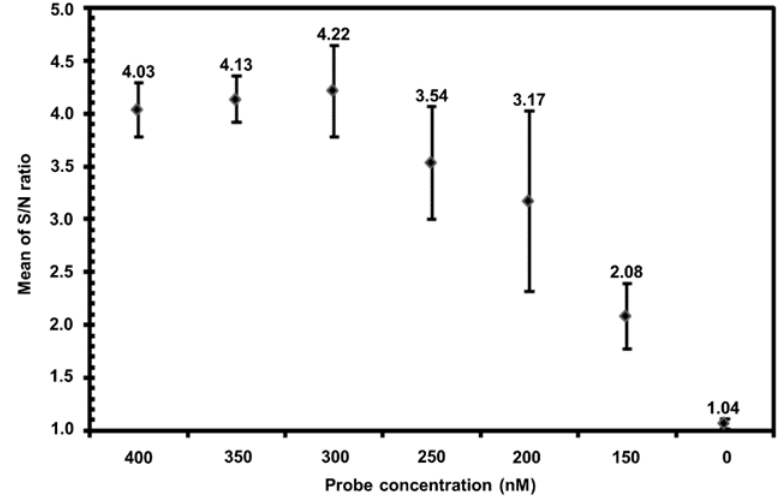
Figure 1. Determination of the optimal probe concentration for insulated isothermal PCR assay of Fusarium oxysporum (Fo iiPCR). Different concentrations (ranging from 0 to 400 nM) of the iipFo-1 probe were used for Fo iiPCR. The mean optical fluorescent signals (signal-to-noise (S/N) ratios) of each reaction recorded by the POCKIT™ analyzer at a wavelength of 520 nm were calculated and plotted against each input concentration of the probe. Each error bar denotes the standard deviation of the mean of seven replicate reactions.